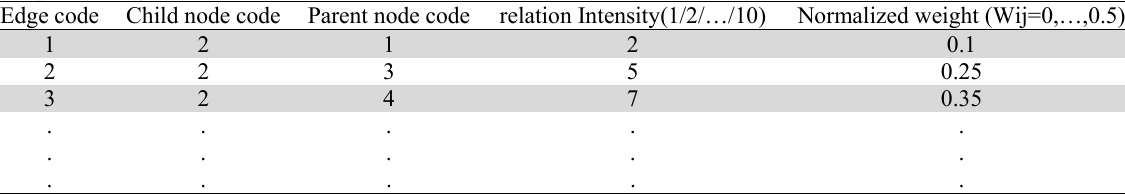
Table 4 Sample of edge